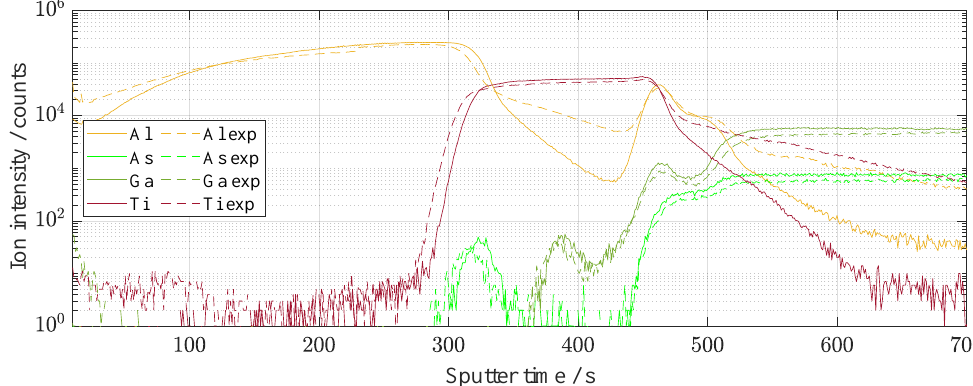
Figure 11. The first few etched tens of nanometers of the solar cell surface in detail using SIMS. The change in Al is especially visible. The difference is visible before and after illumination of 67 days.